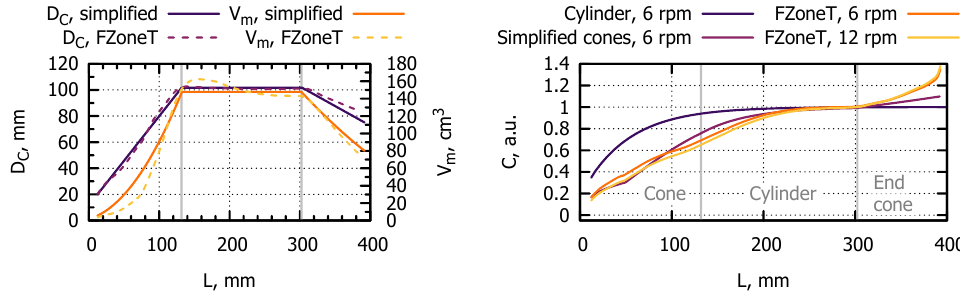
Figure 18. The crystal diameter and melt volume as a function of the crystal length L for the consid- ered D C = 102 mm system with cone stages ( left ) and comparison of the axial carbon concentration in the crystal using different crystal shapes with k eff ( D C ) from the melt flow simulation results ( right ). Vertical grey lines represent the boundaries between the start cone, cylinder and end cone